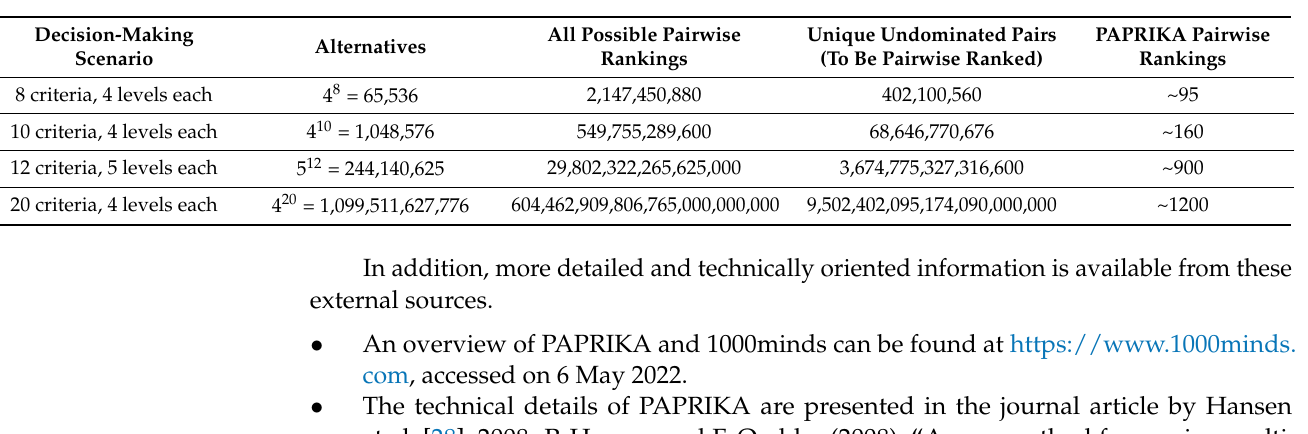
Table A6. The necessary number of pairwise rankings (https://www.1000minds.com accessed on 6 May